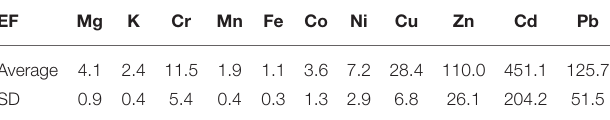
TABLE 2 | Enrichment factor of different trace elements. EF